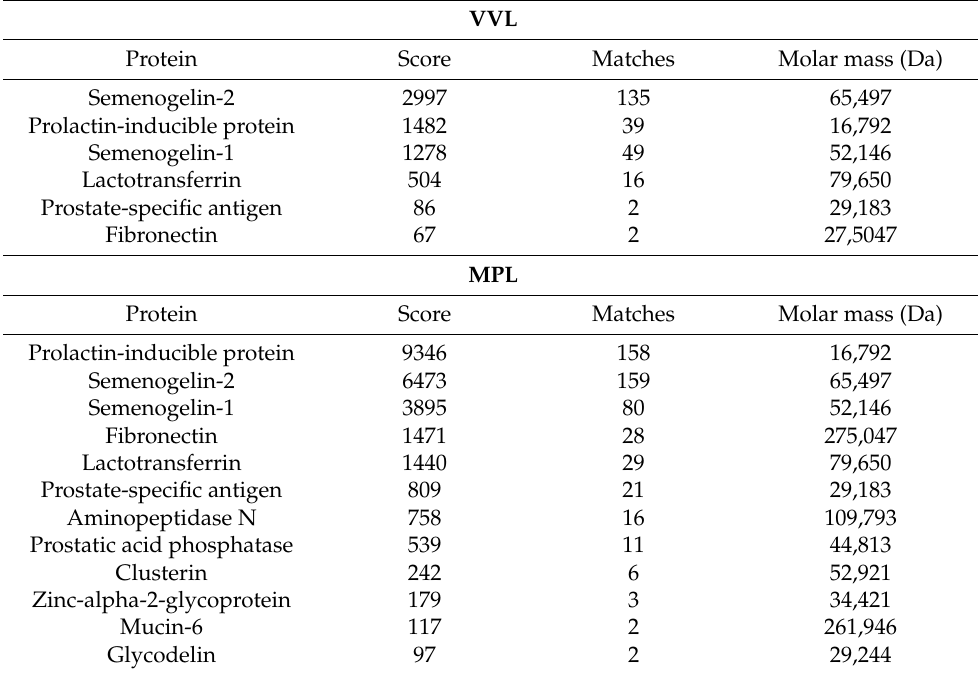
Table 2. LC-MS identification of proteins isolated in lectin affinity